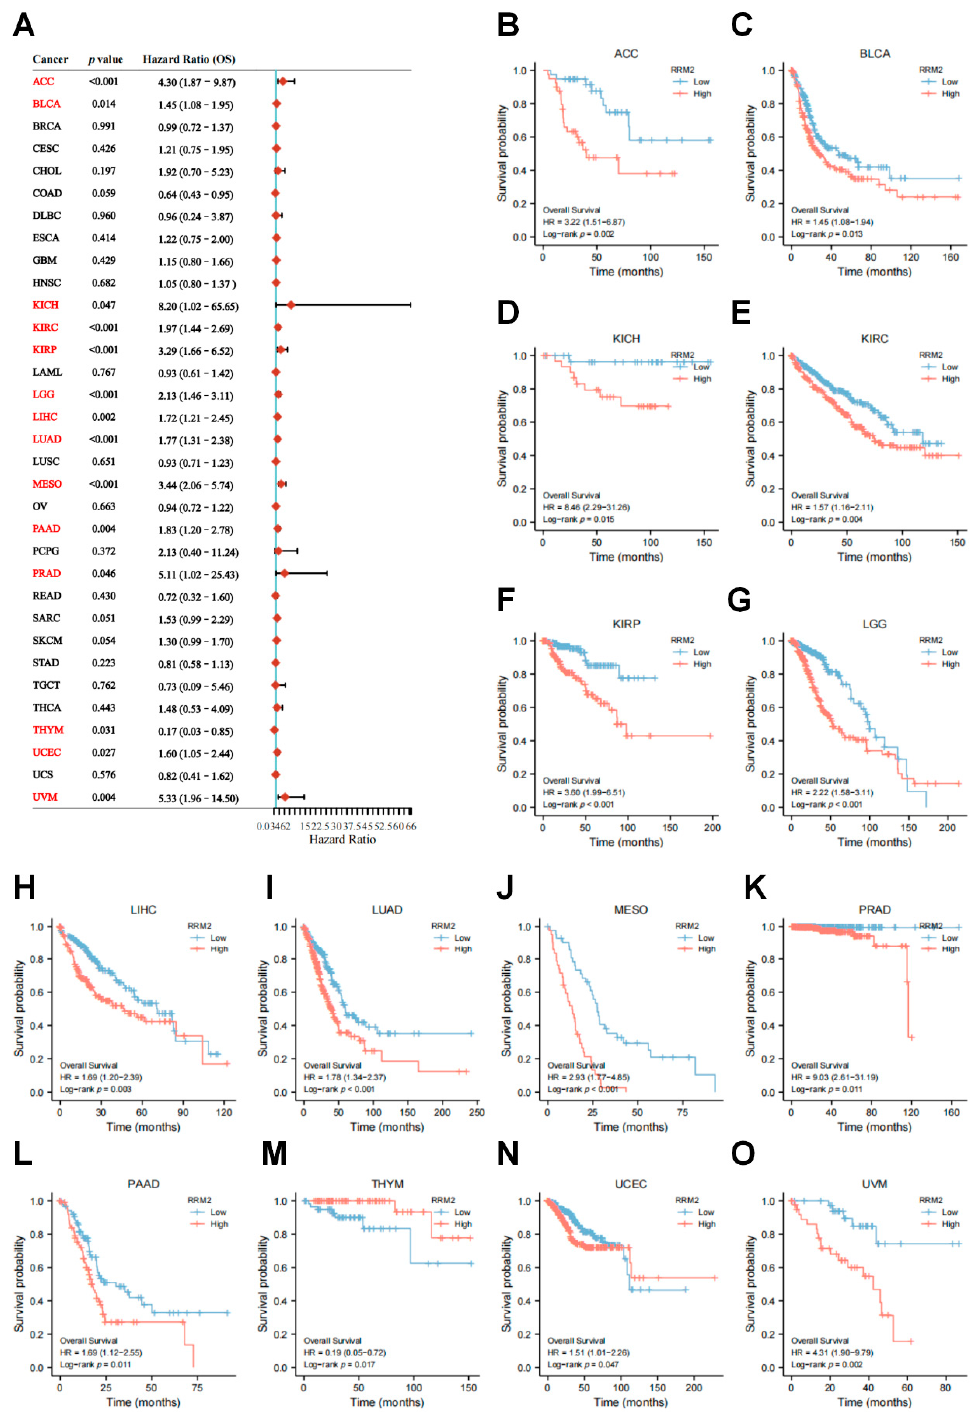
Figure 3. Relationship of RRM2 expression with Overall Survival (OS). ( A ) Forest map shows the univariate Cox regression analysis results for RRM2 in TCGA pan-cancer samples (Red color indicated statistical significance). ( B – O ) Kaplan–Meier OS curves of RRM2 expression in the significantly associated tumors.